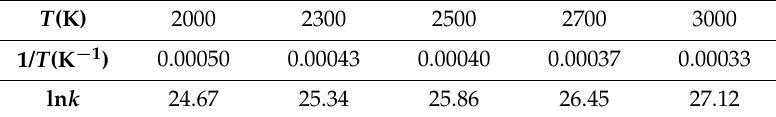
Figure 5. Arrhenius model for meta-aramid fibers. Table 2. Fitting parameters of Arrhenius model.